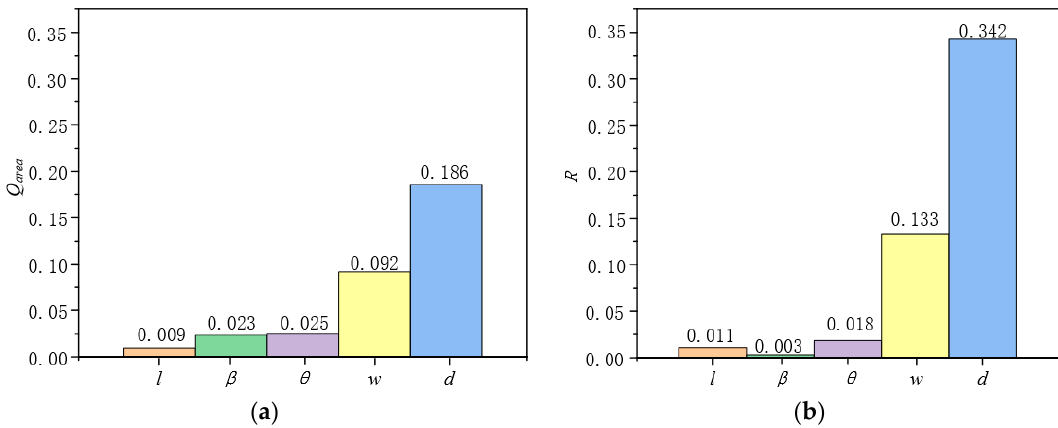
= 2 × 10 7 ), ( b ) lift drag area